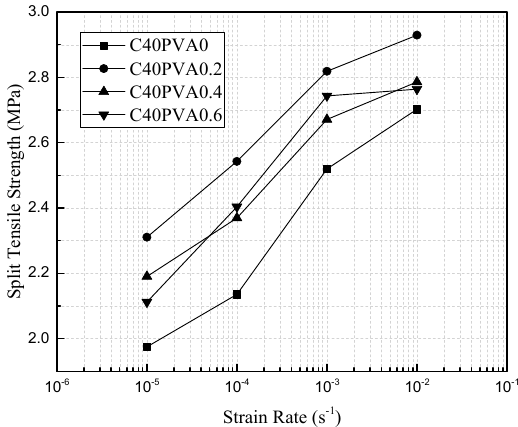
Figure 7. Split tensile strength of FRC (C40).